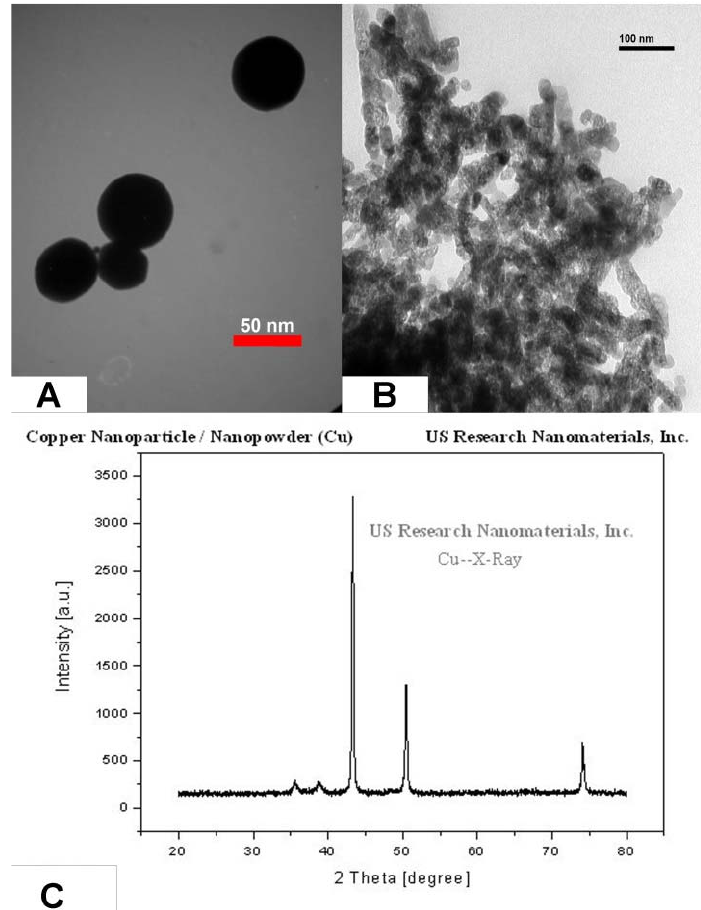
Fig. 1: Specifications of CuNPs used in the experiment: Plate (A) indicate, Transmission Electron Microscopy (TEM) illustration, scale bar=50 nm; Plate (B) indicate, Scanning Electron Microscopy (SEM) illustration, scale bar=100 nm; Plate (C) indicate, size distribution of CuNPs.